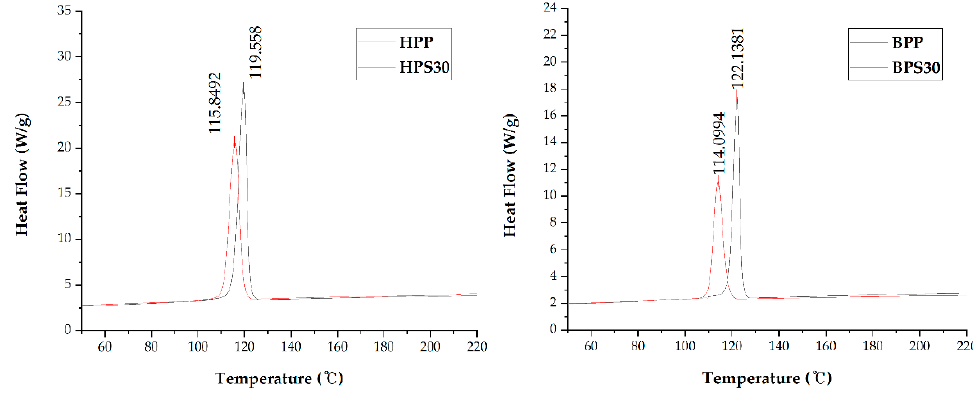
Figure 3. X ray diffraction (XRD) result of SOC powder and PP/SOC specimens.